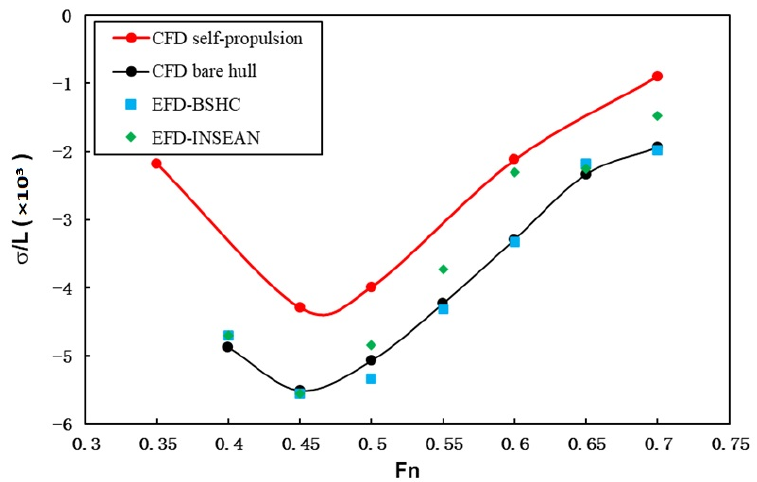
Figure 12. The comparison of sinkage between CFD and EFD results for self-propulsion catamaran.